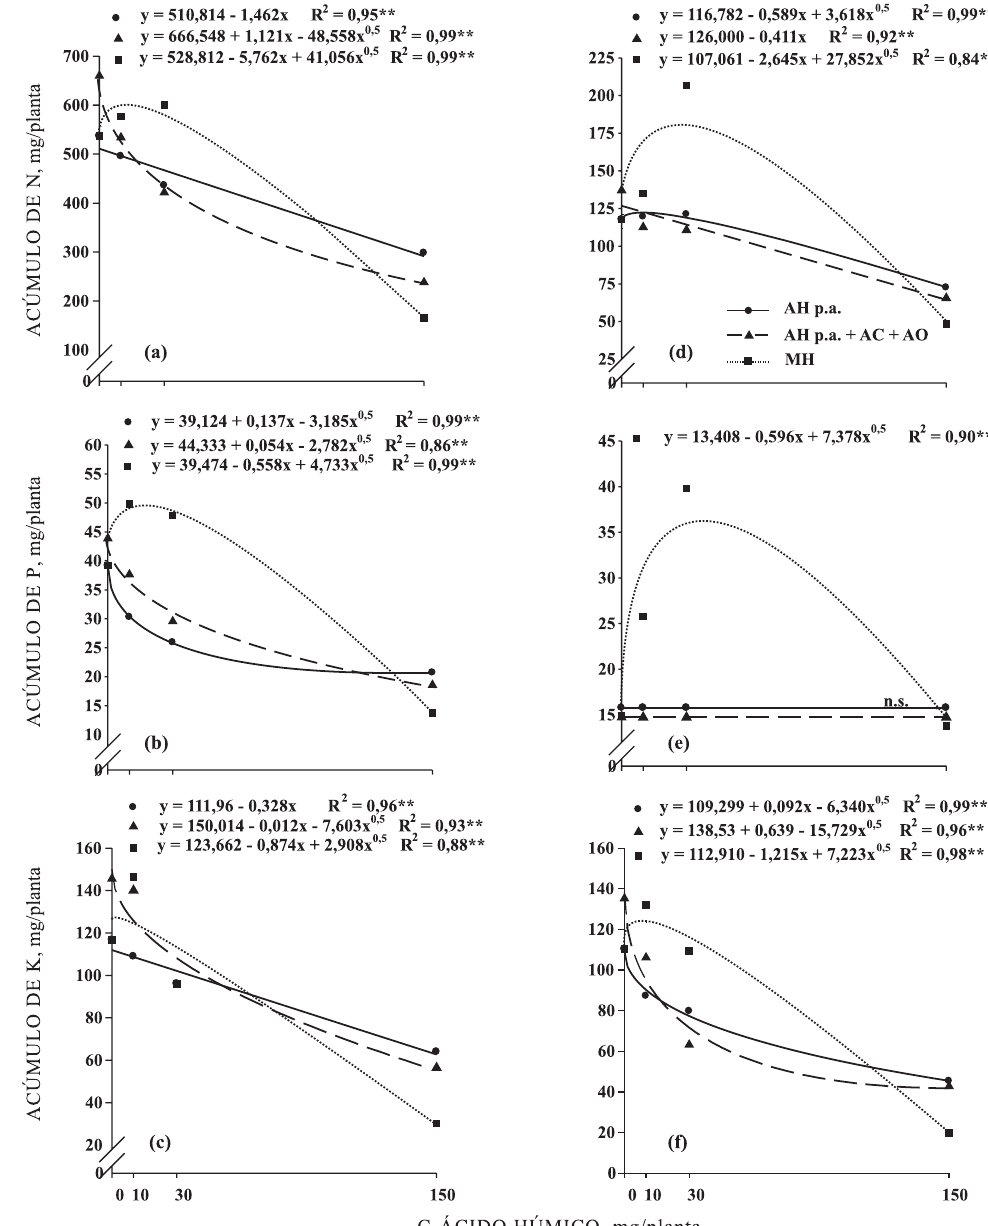
Figura 5. Acúmulo de N, P e K na matéria seca das folhas (a, b, c) e do caule (d, e, f) de mudas de eucalipto, em resposta ao aumento de concentrações de C-ácido húmico em solução nutritiva. AH p.a.: ácido húmico p.a.; MH: material húmico; AC: ácido cítrico; AO: ácido oxálico; ns: não